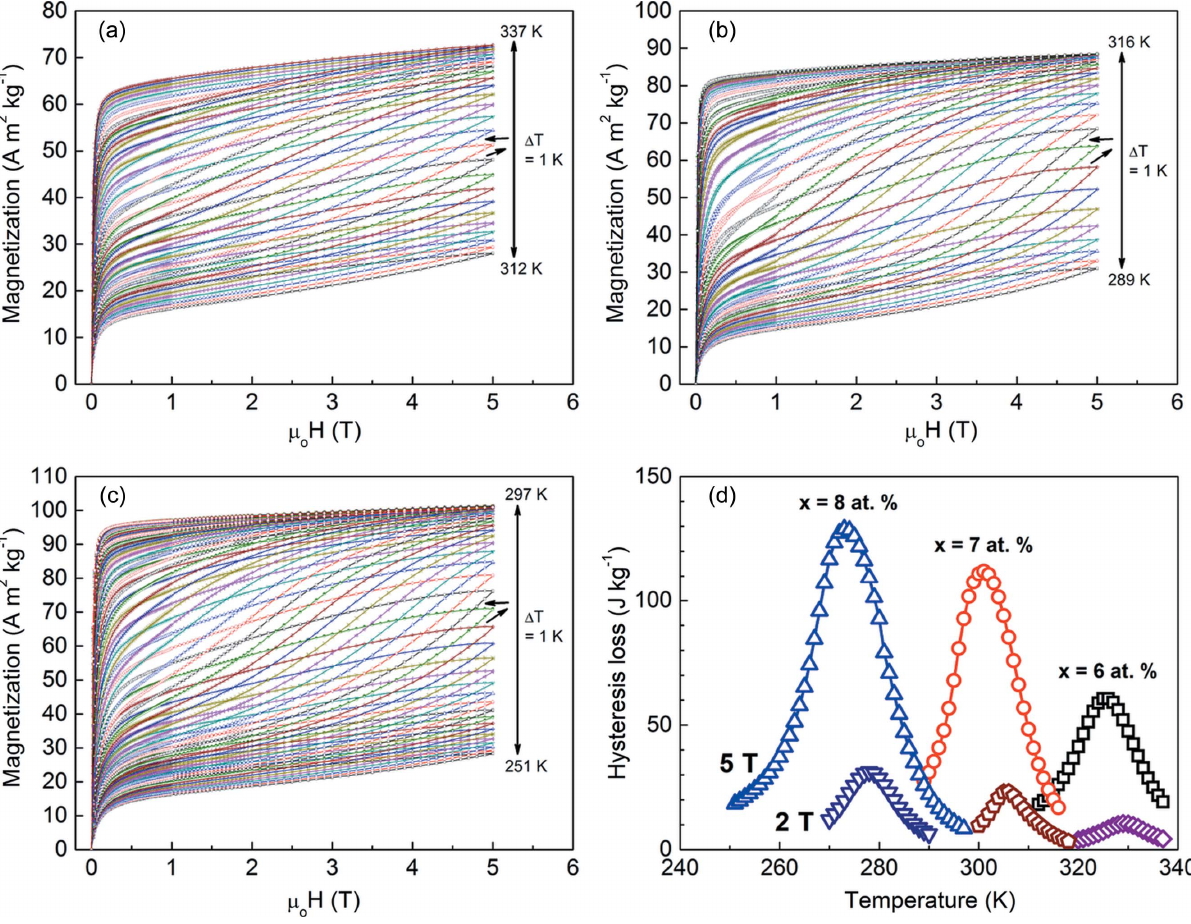
Figure 11 ( a )–( c ) Isothermal magnetization curves measured on increasing and decreasing the magnetic field up to (cid:2) 0 H max = 5 T through the inverse martensitic transformation for ( a )